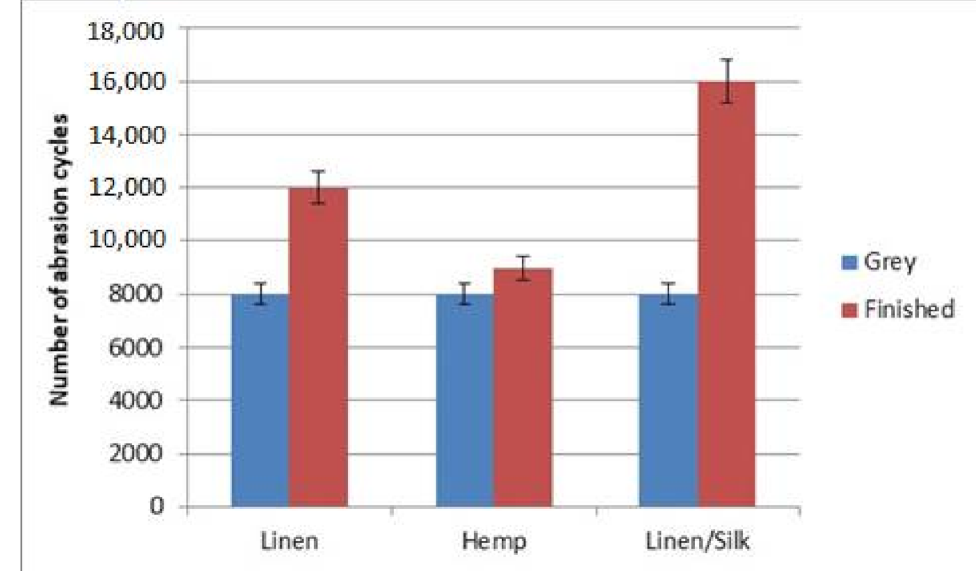
Figure 12. Diagram of abrasion resistance.